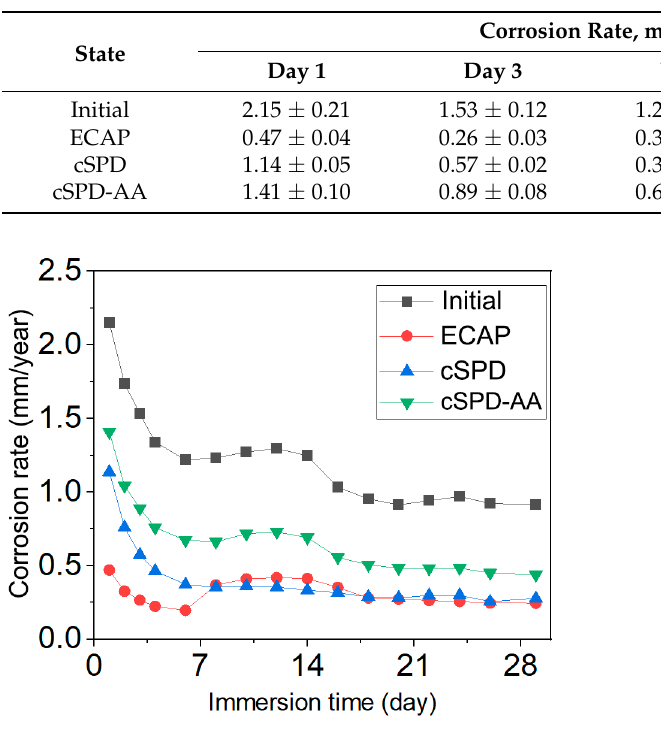
Figure 7. Corrosion rate of the Mg-2Sr alloy in different structural states after immersion in Ringer’s solution for exposure time up to 30 days. Table 3. Corrosion rates of the Mg-2Sr alloy in different structural states.